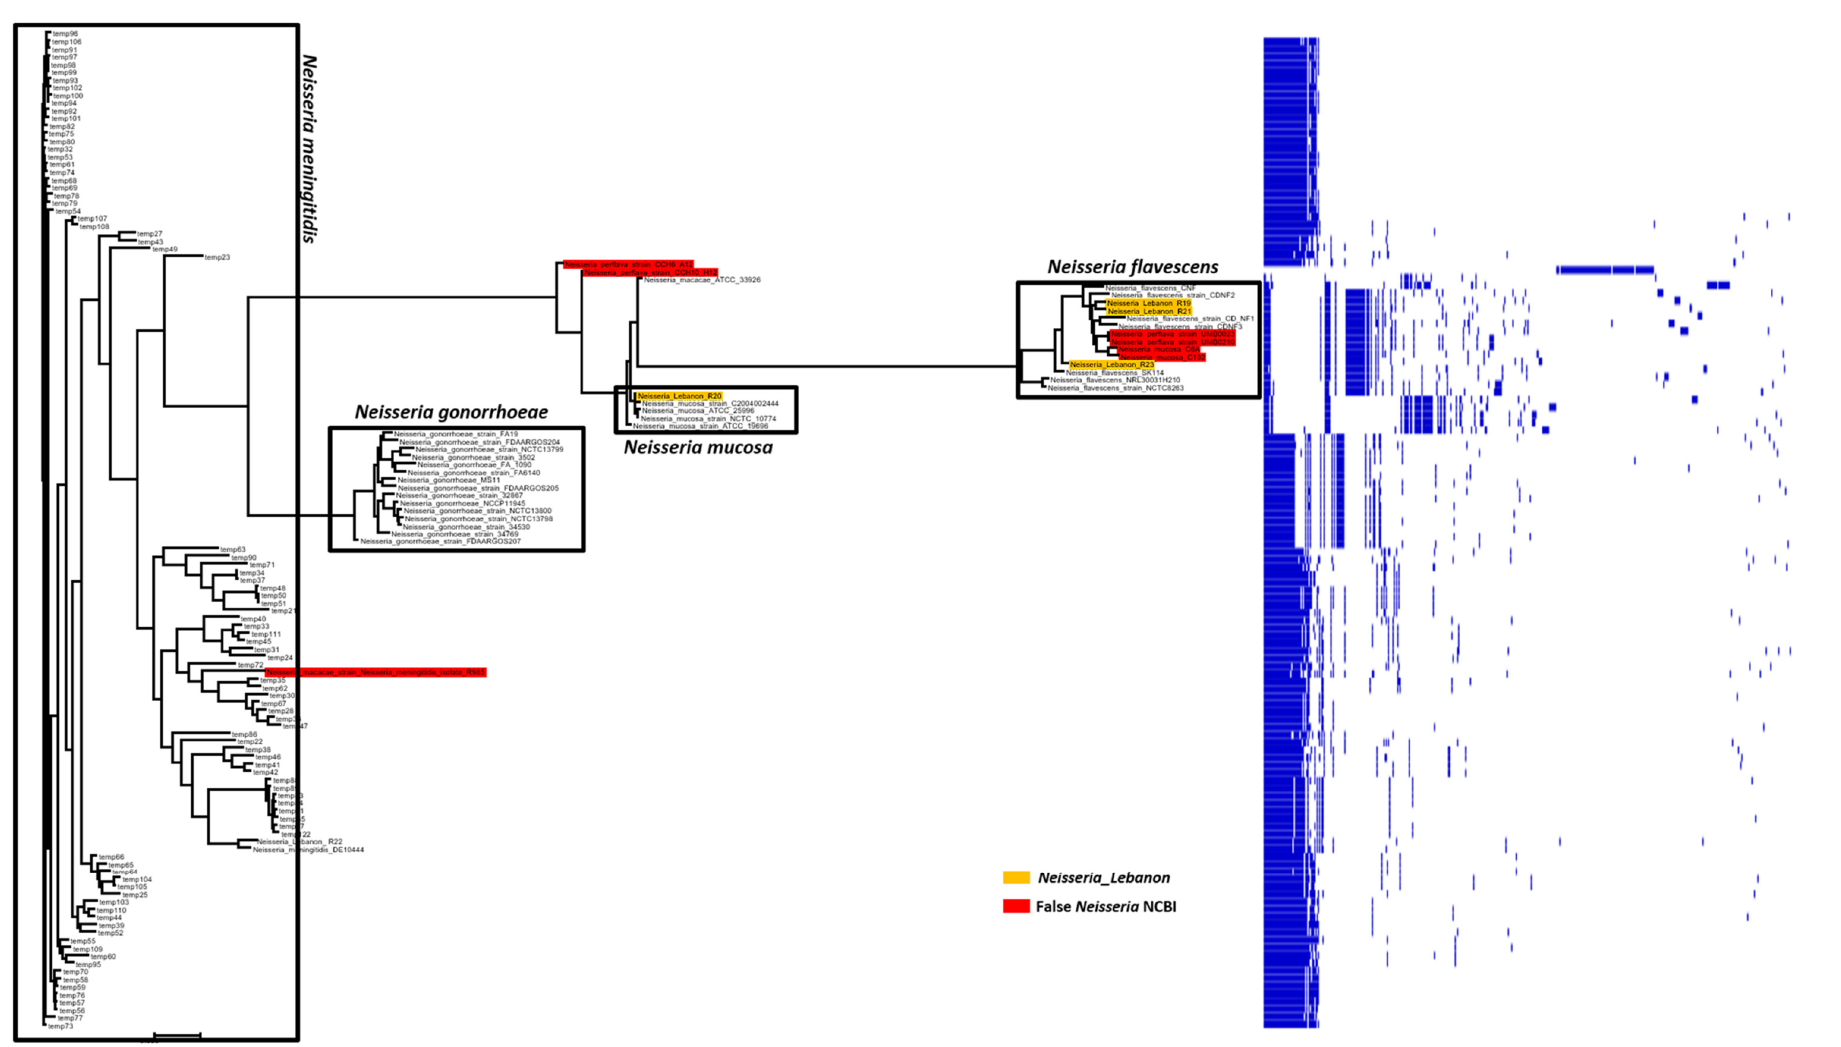
Figure 3. Pangenome tree of Neisseria isolated in Lebanon with 128 Neisseria spp. available in the NCBI GenBank database.